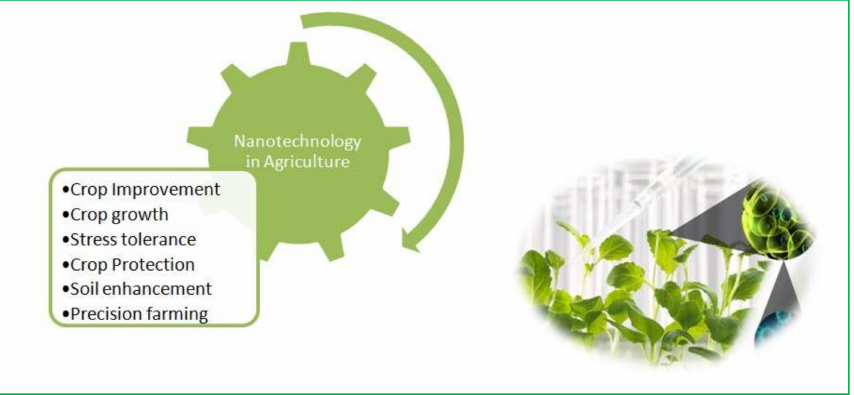
Figure 1. Various applications of nanotechnology in agriculture. Created with Biorender.